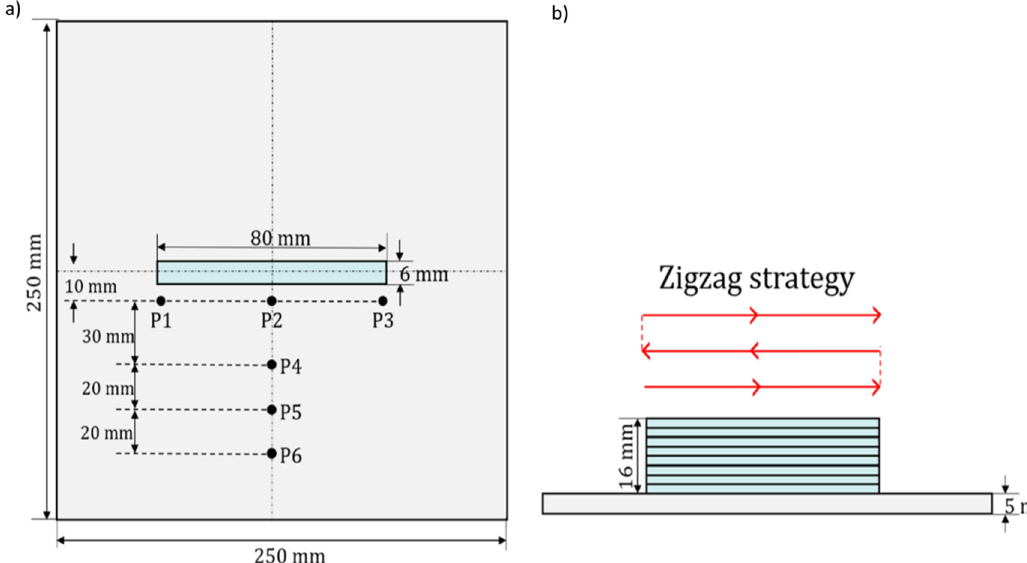
Fig. 5. Part geometry, trajectories and thermocouple positions to validate the fi nite element model: (a) Top view, (b) Front view.